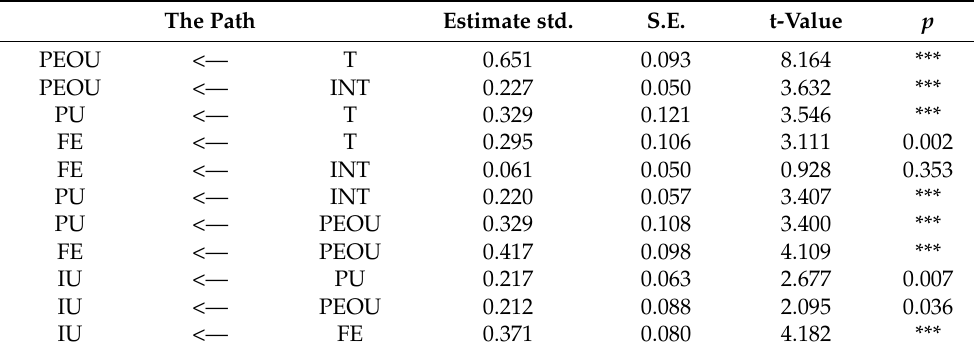
Table 7. Path coefficient analysis of the structural equation.